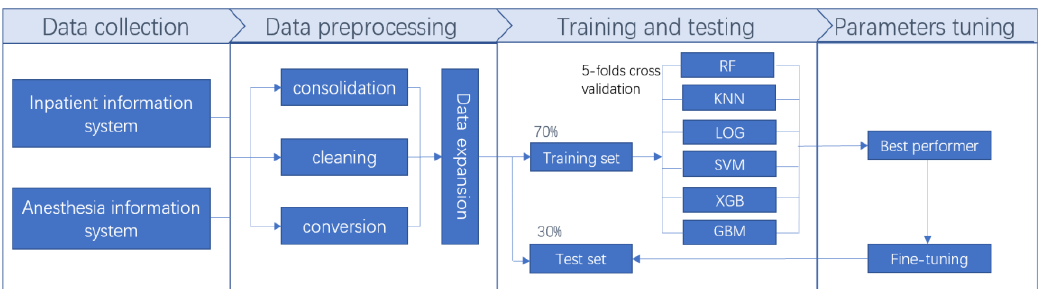
Figure 3. Flow diagram of the study.